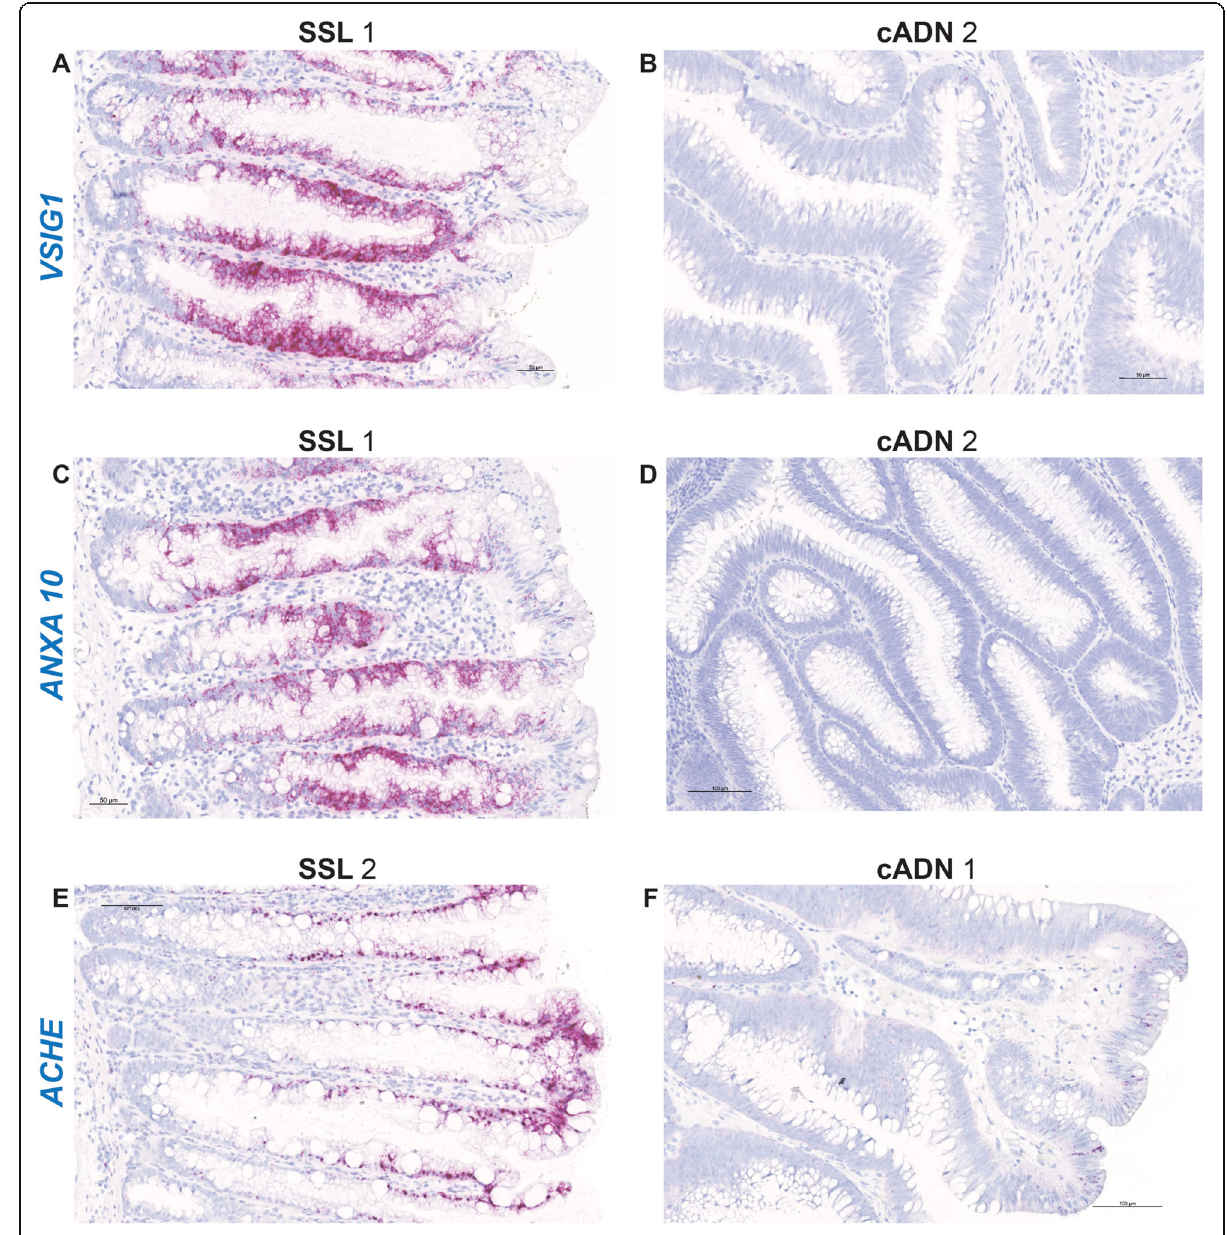
Fig. 2 In situ hybridization analysis of VSIG1 , ANXA10, and ACHE mRNAs in SSLs and cADNs. All three markers are strongly positive in SSLs (dense red punctate labeling in panels A , C , and E , reflecting “ very high ” expression (see scoring system depicted in Fig. 1) but absent in cADNs (panels B , D , and F ) with the exception of few ANXA10 - or ACHE -positive cells on their surface. While VSIG1 and ANXA10 are expressed in most of the longitudinal axis of the serrated glands, except their bottoms and tops, ACHE expression involves mainly the upper half of these crypts. Details on the expression patterns of these three mRNAs in the investigated lesions and in normal mucosa are shown in Supplementary Figs. 4, 5 and 6. Lesions are numbered as in Table